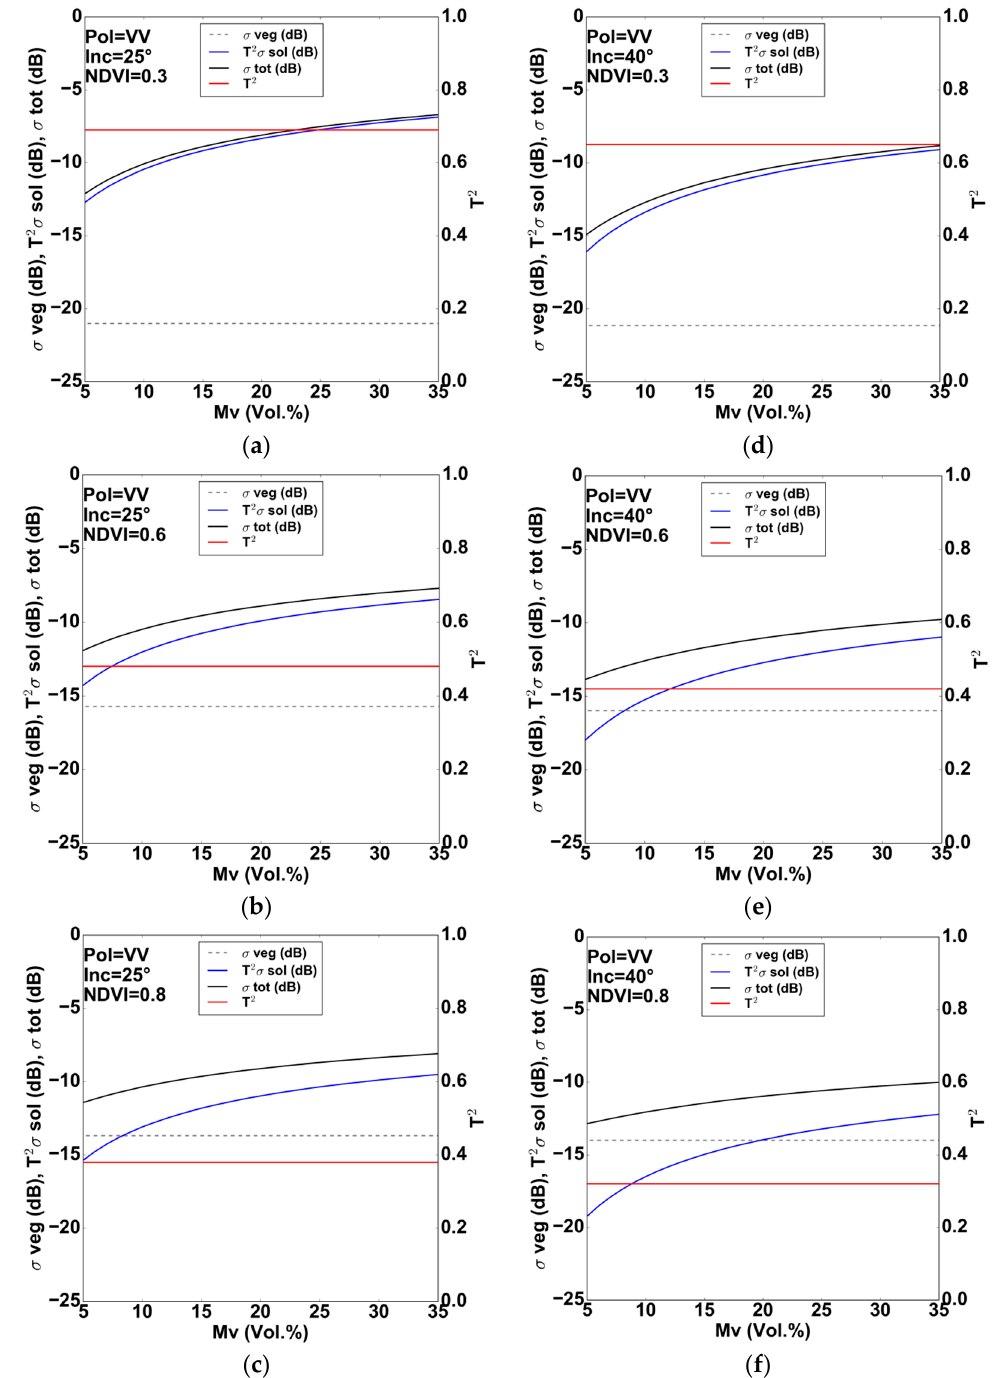
Figure 3. Behavior of WCM components ( σ 0veg , T 2 σ 0soil , and σ 0tot ) in VV polarization according to mv for 25° and 40° incidence angles. The soil roughness Hrms was fixed to 2 cm. ( a ): θ = 25° and NDVI = 0.3; ( b ): θ = 25° and NDVI = 0.6; ( c ): θ = 25° and NDVI = 0.8; ( d ): θ = 40° and NDVI = 0.3; ( e ): θ = 40° and NDVI = 0.6; ( f ): θ = 40° and NDVI = 0.8.